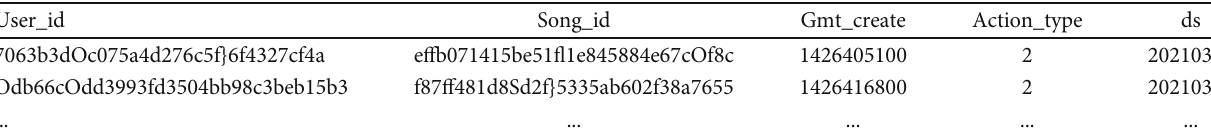
Table 2: User operation table.